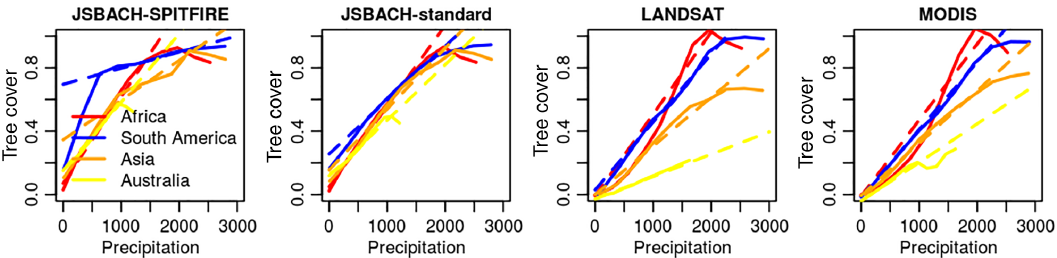
Figure 5. Modelled and observed relationship between precipitation and maximum tree cover based on a linear quantile regression (dashed line) and a local quantile regression (solid line). Different colours indicate the different